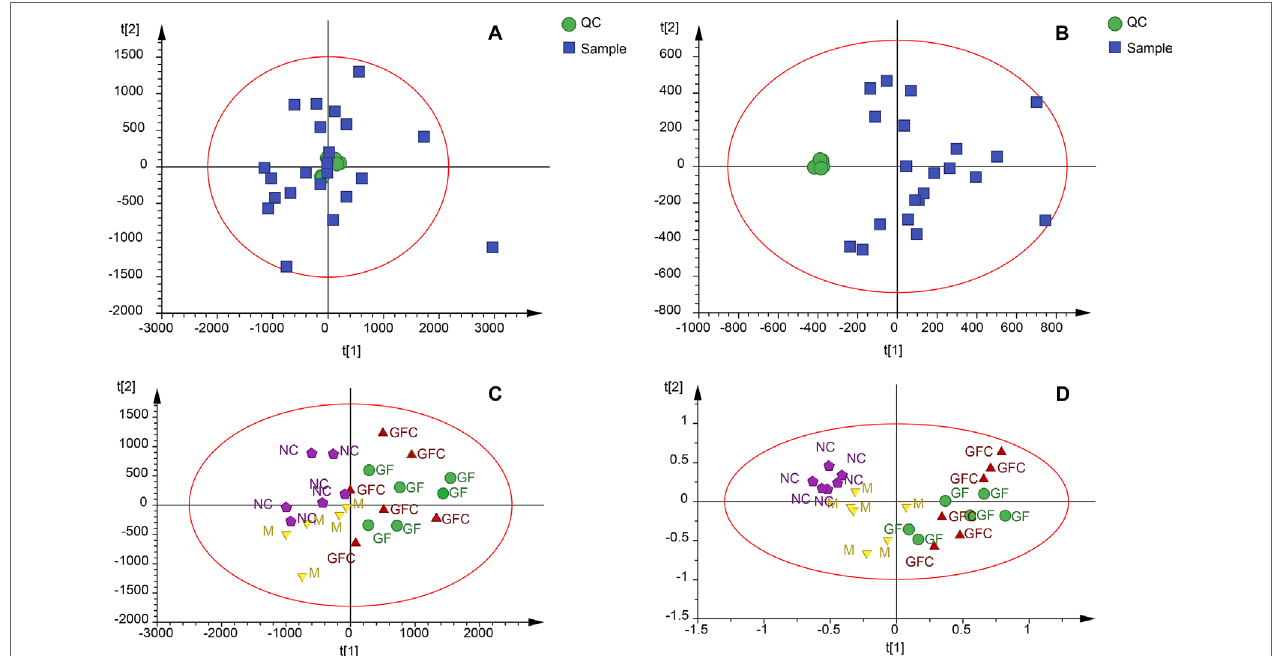
FIGURE 3 | Quality control samples (QCs) evaluation and principal components analysis (PCA) plots in the HILIC and C18 separation modes. (A) QCs in the C18/ UHPLC/MS system; (B) QCs in the HILIC separation mode; (C) PCA plot of all samples in the C18/UHPLC/MS system; (D) PCA plot of all samples in the HILIC separation. QCs clustered together in both the C18 and HILIC systems. PCA plots showed that the GF and GFC groups were separated from the M